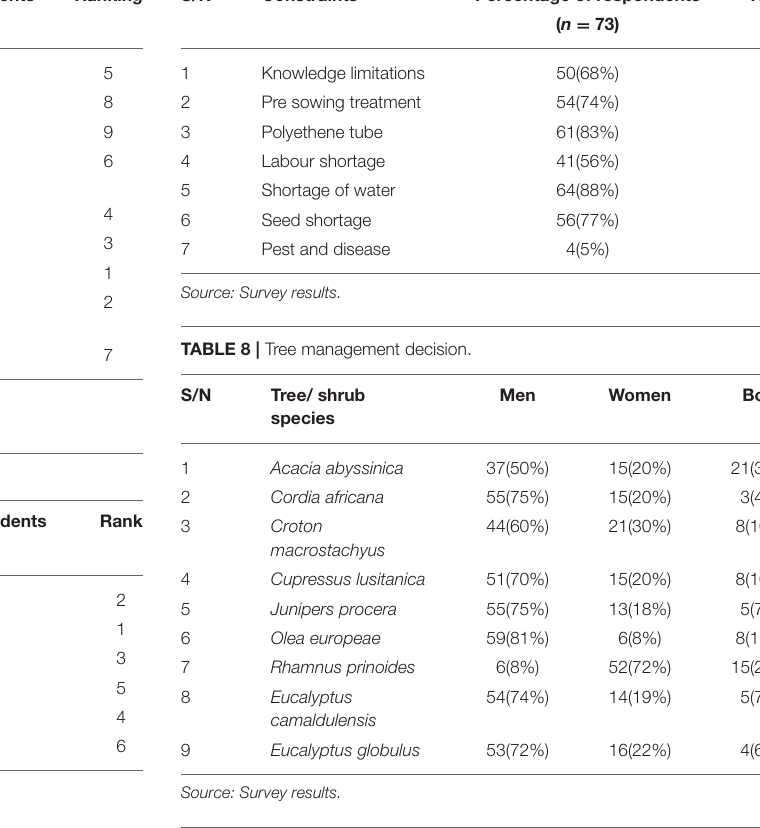
TABLE 9 | Opportunities for managing